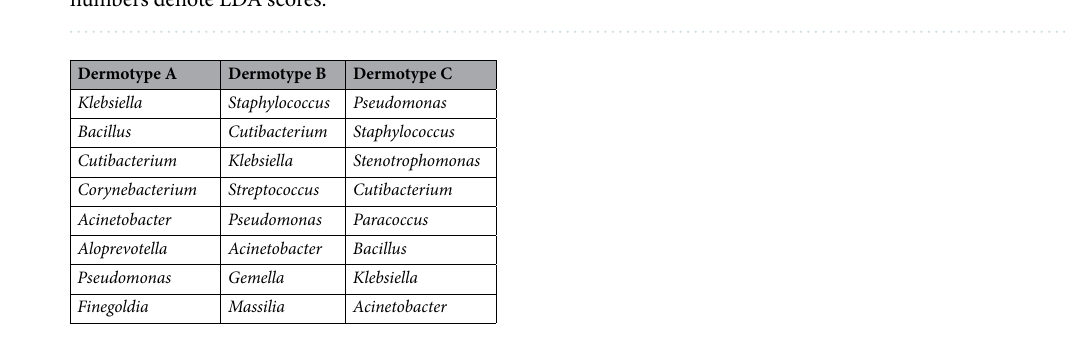
Table 2. Dermotypes that were detected in cutaneous